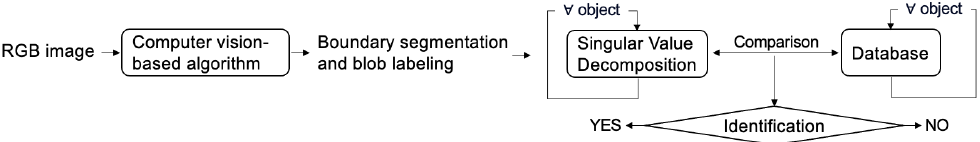
Figure 8. Flow chart of algorithm processing